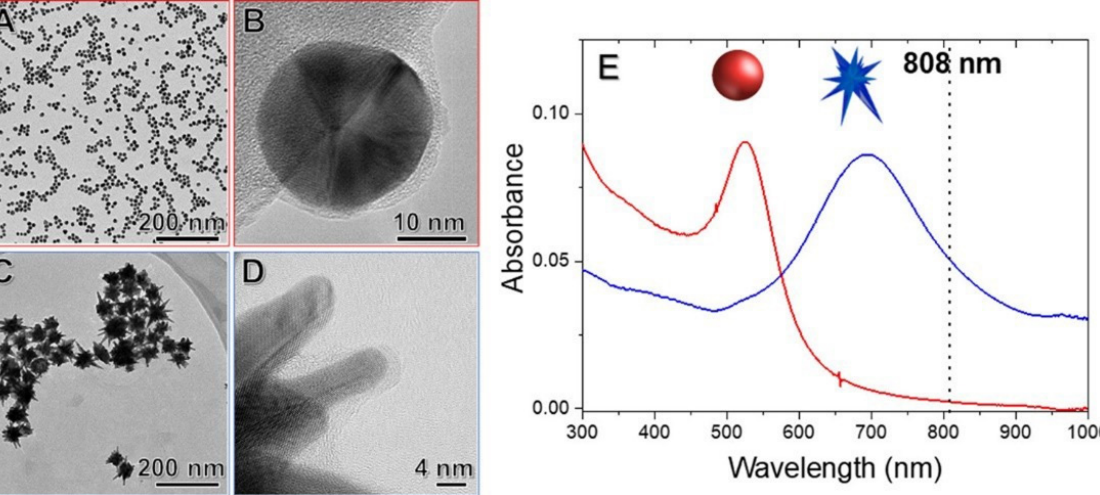
Figure 3. ( A , B ) TEM images of AuNSp@CALB; ( C , D ) TEM images of AuNSt@CALB; ( E ) UV − vis spectra of AuNSp@CALB (red line) and AuNSt@CALB (blue line). Reprinted with permission from de Barros et al., American Chemical Society [14].